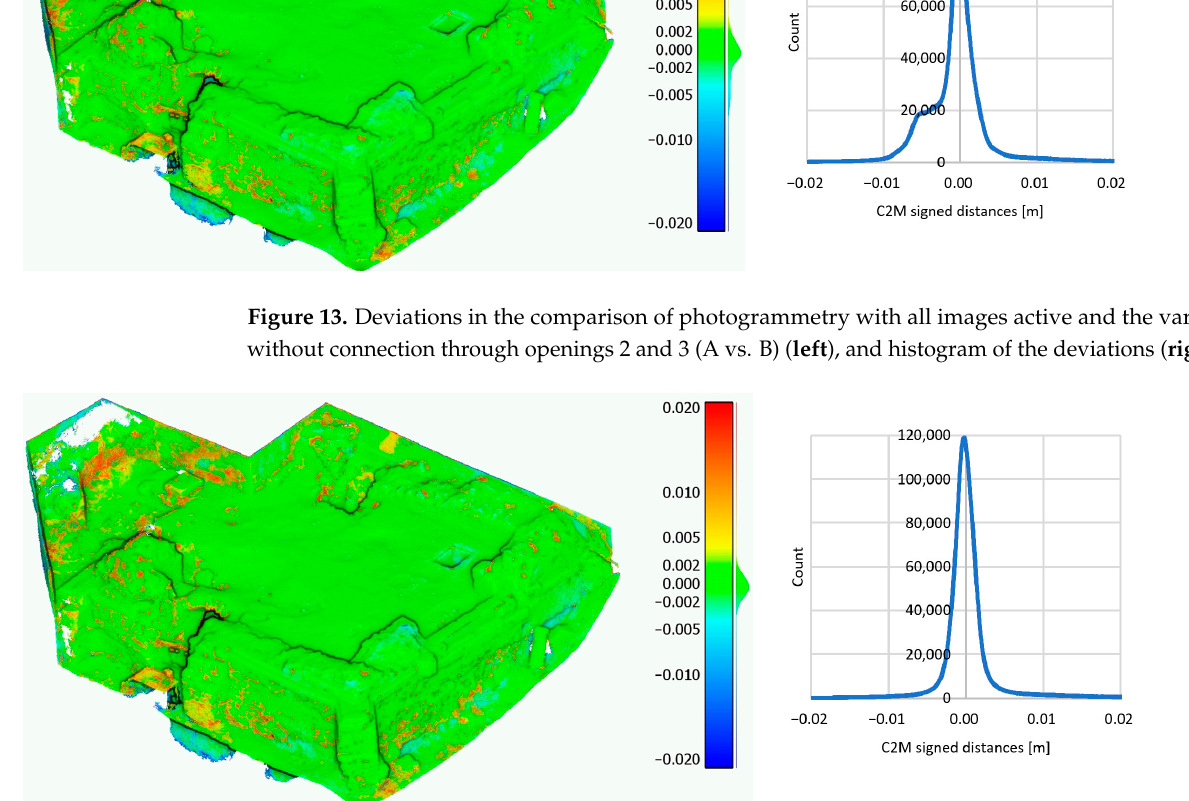
Figure 14. Deviations in the comparison of photogrammetry with all images active and the variant without connection through opening 3 (A vs. C) ( left ), and histogram of the deviations ( right ).